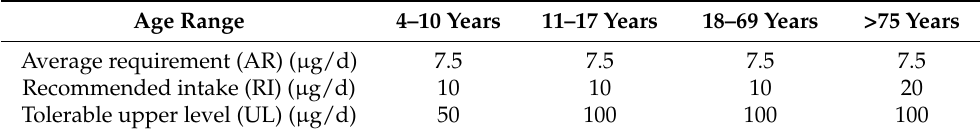
Table 1. Constraints of vitamin D consumption for different age groups of the Danish population.